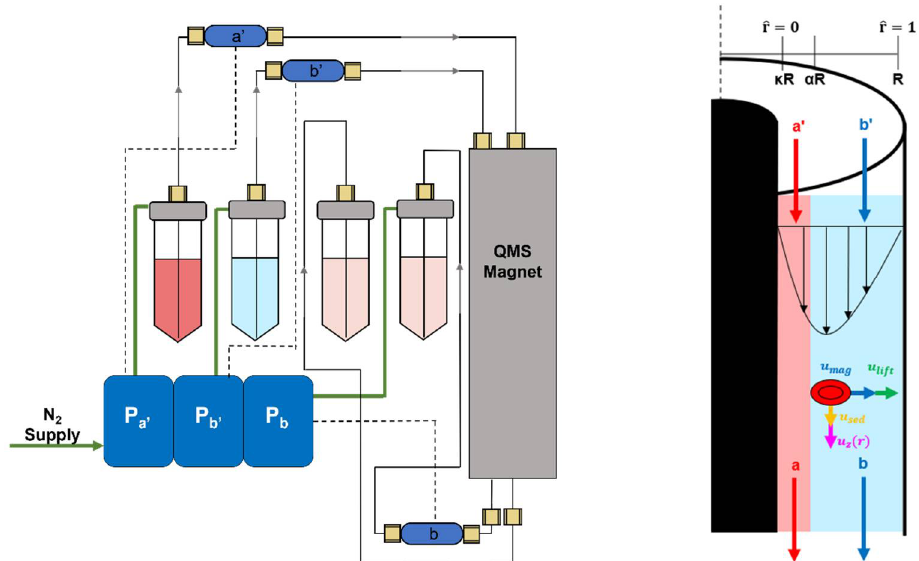
Figure 1. A schematic of the pressure driven flow system ( left ) shows that pressurized air/N 2 (green) exits the pressure control units (blue), pressurizes the headspace in the sample tubes through a port on the side of the airtight lid, and the cell suspension travels through PEEK tubing that exists the top of the container. The RBC-rich (a’) and buffer (b’) feed streams enter the annulus embedded in the bore of the QMS permanent magnet, pass though, and exit as the nonenriched (a) and enriched (b) outlets. Downstream of the magnet, these streams pass through flow sensors and data lines (dotted) provide feedback to the corresponding pressure controller. The pressure controller on the (b) stream provides backpressure into the QMS to achieve the desired outlet setpoints and (a) is left uncontrolled and open to atmosphere. The unitless radius, r(cid:3548) , is illustrated ( right ) with the inner wall (κR) and interface (αR) coordinates, and resulting axial velocity profile induced on a RBC inside the QMS.